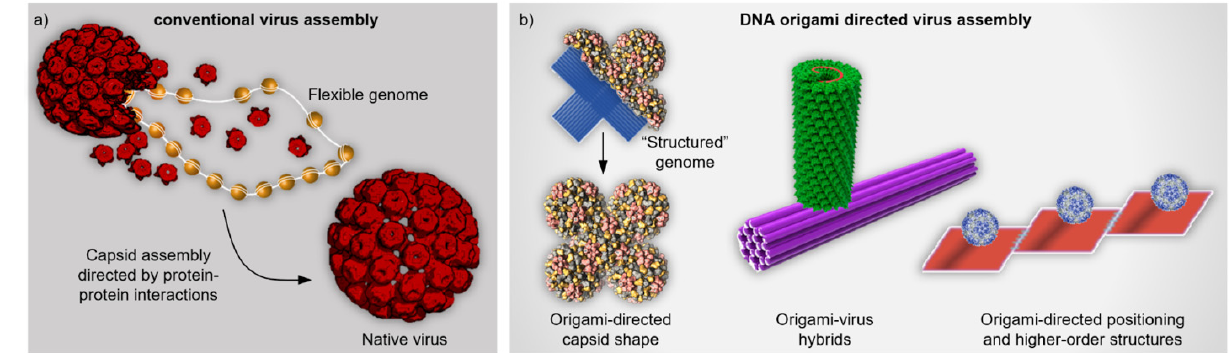
Figure 1. Comparison between conventional and DNA origami directed virus assembly. ( a ) Conventional virus assembly. Capsid proteins (CP, red) assemble into a complete native virus capsid through protein-protein interactions and simultaneously package the flexible genome (DNA or RNA) into it [39]. ( b ) DNA origami directed virus assemblies. Left: Virus capsid takes a non-native shape as the viral CPs assemble on top of the templating DNA origami that serves as “structured” genomic material similarly as in Ref. [40]. Middle: Tobacco mosaic virus (TMV) capsid assembles at the specific location of the DNA origami template. The capsid forms around the protruding RNA strand that contains a characteristic loop as an origin-of-assembly sequence [41]. Right: Virus capsids are bound to DNA origami platforms which are further assembled into higher-order structures [42]. ( a ) reproduced with permission from [39]. Copyright Royal Society of Chemistry, 2020. ( b ) Middle panel reproduced with permission from [41]. Copyright American Chemical Society, 2018. Right panel reproduced with permission from [42]. Copyright American Chemical Society, 2010.